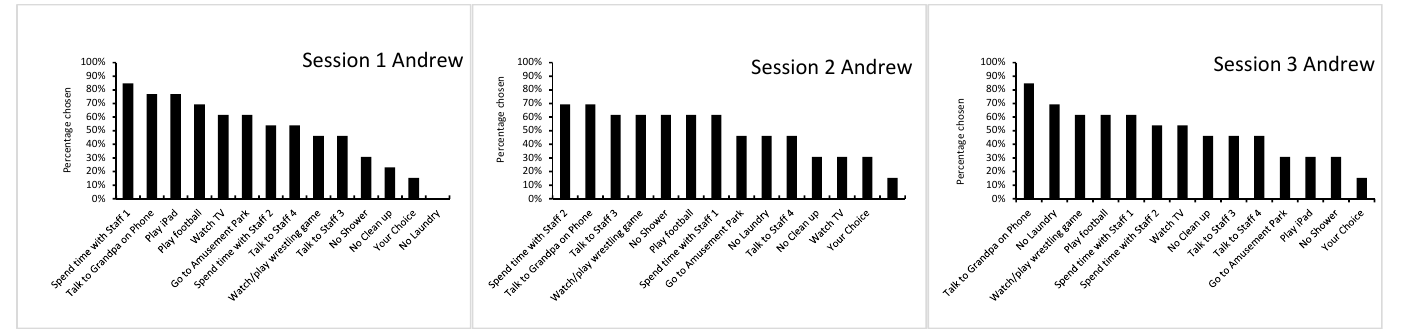
Figure 1. The percentage chosen allocated to each stimulus across the three sessions of the pictorial concurrent operant preference assessment for each participant.